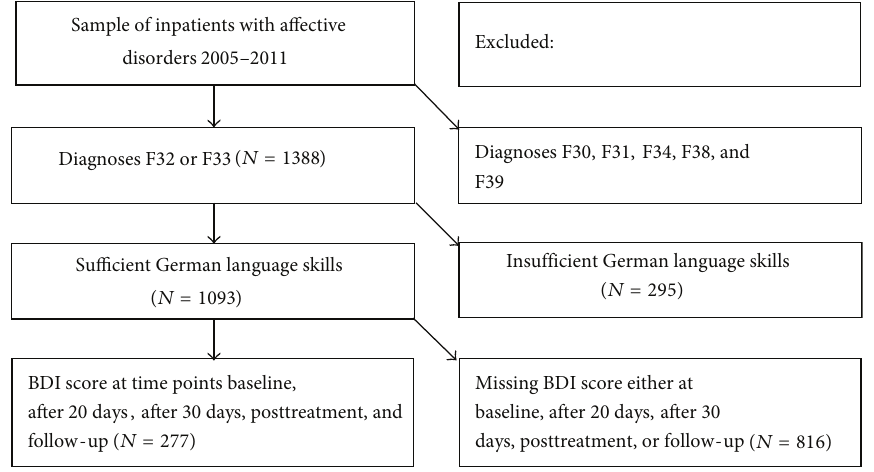
Figure 1: Flow chart: recruitment of